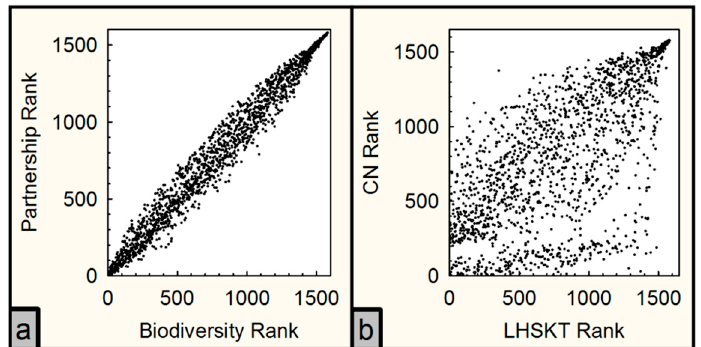
Figure 4. Depiction of how the conservation priority rank of all sites compared between ( a ) the partnership and biodiversity outputs (r s = 0.98); and ( b ) CapeNature and Leslie Hill Succulent Karoo Trust outputs (r s = 0.66). Each dot represents a site.